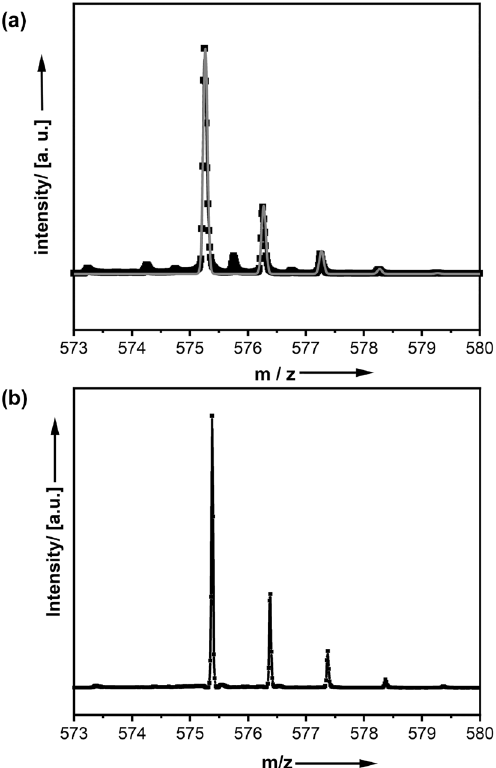
Figure 3. Characterization of Sc-DO3A-C 11 -SH surfactant synthesized according to Fig. 1b. ( a ) ESI–MS pattern of Sc-DO3A-C 11 -SH; black = experimental pattern, grey = pattern simulated for M = [Sc-DO3A-C 11 -SH] H + . ( b ) ESI–MS pattern after 48 h at pH